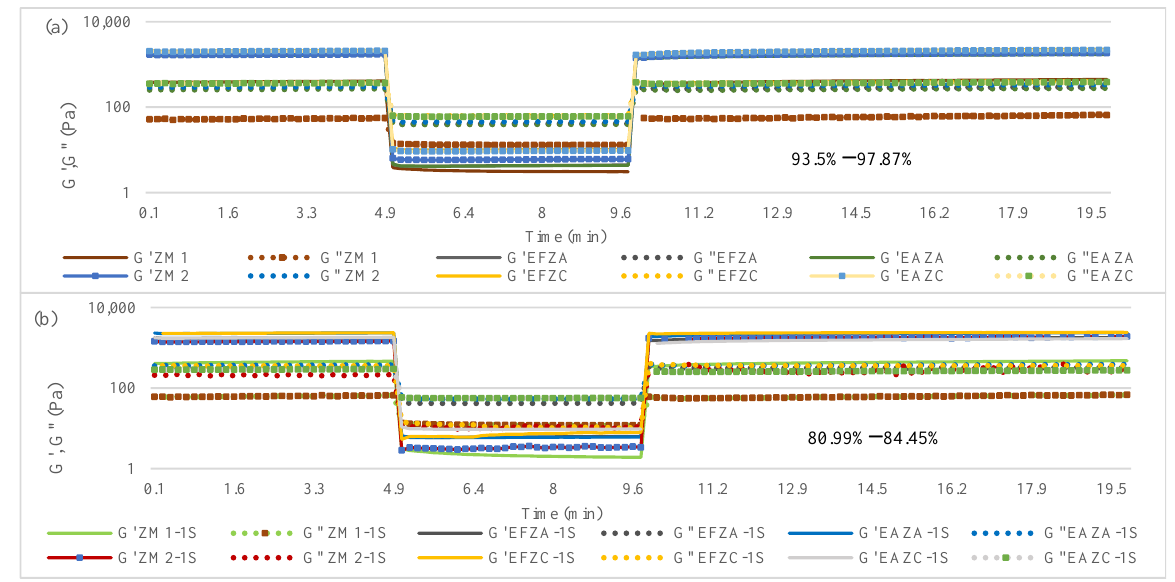
Figure 5. Time-dependent rheological behavior of zucchini purees supplemented with 6% aqueous anise/fennel extract fresh samples ( a ) and one-week stored samples ( b ). ZM 1 and ZM 2 are zucchini purees treated by steam convection and hot air convection, respectively; EFZA and EAZA are zucchini purees mixed with fennel or anise aqueous extract, processed by steam convection; EFZC and EAZC are zucchini purees mixed with fennel or anise aqueous extract, treated by hot air convection; “-1S” is added at each sample to differentiate one week of storage at refrigeration temperature.